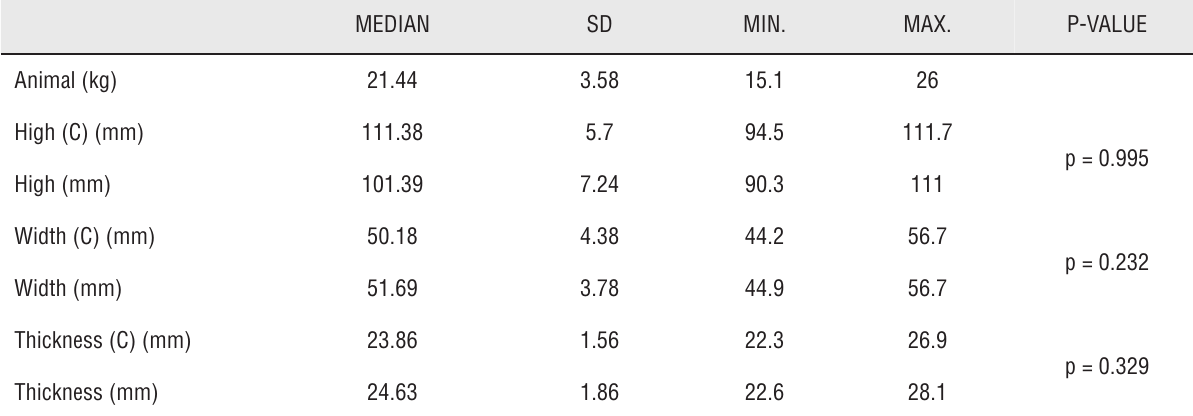
Table 1 - Sample data of the animals submitted to thermoablation using radiofrequency.